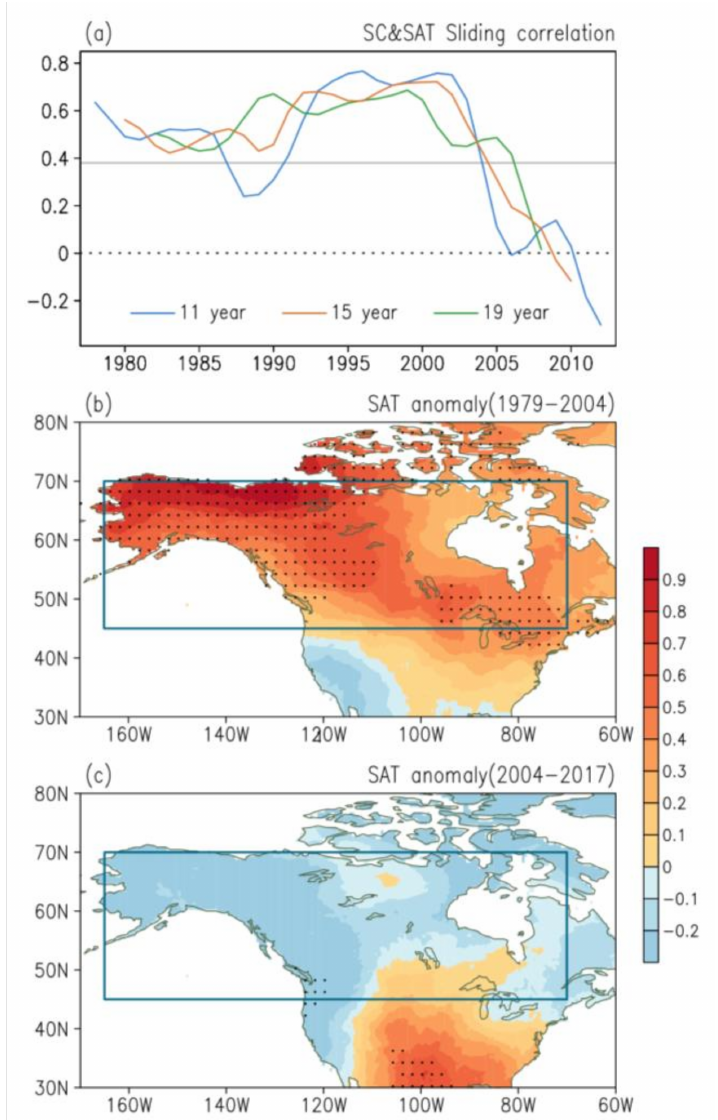
Figure 4. ( a ) Sliding correlation coefficients between the spring eastern TP snow cover (27.5 ◦ –37.5 ◦ N, 89 ◦ –103 ◦ E) and the spring northern of North America surface air temperature (SAT) with an 11-year (blue line), 15-year (orange line), and 19-year (green line) moving window for the period 1973–2017. The gray line denotes that the 15-year sliding correlation coefficient is significant at the 95% confidence level. Anomalies of SAT ( ◦ C) in spring obtained by linear regression against the spring interannual snow cover index in the eastern TP region for the period ( b ) 1979–2004 and ( c ) 2005–2017. The dotted regions in ( b , c ) denote anomalies significant at the 95% confidence level. The box covered areas in ( b , c ) denote the domain for the northern North American region. The analysis is based on the NSIDC snow cover data [27] (https://nsidc.org/data/NSIDC-0046/versions/4 (accessed on 24 January 2023)) and the CRU SAT data [61] (http://www.cru.uea.ac.uk/data/ (accessed on 24 January 2023)). (Based on modification of Wang et al., 2020